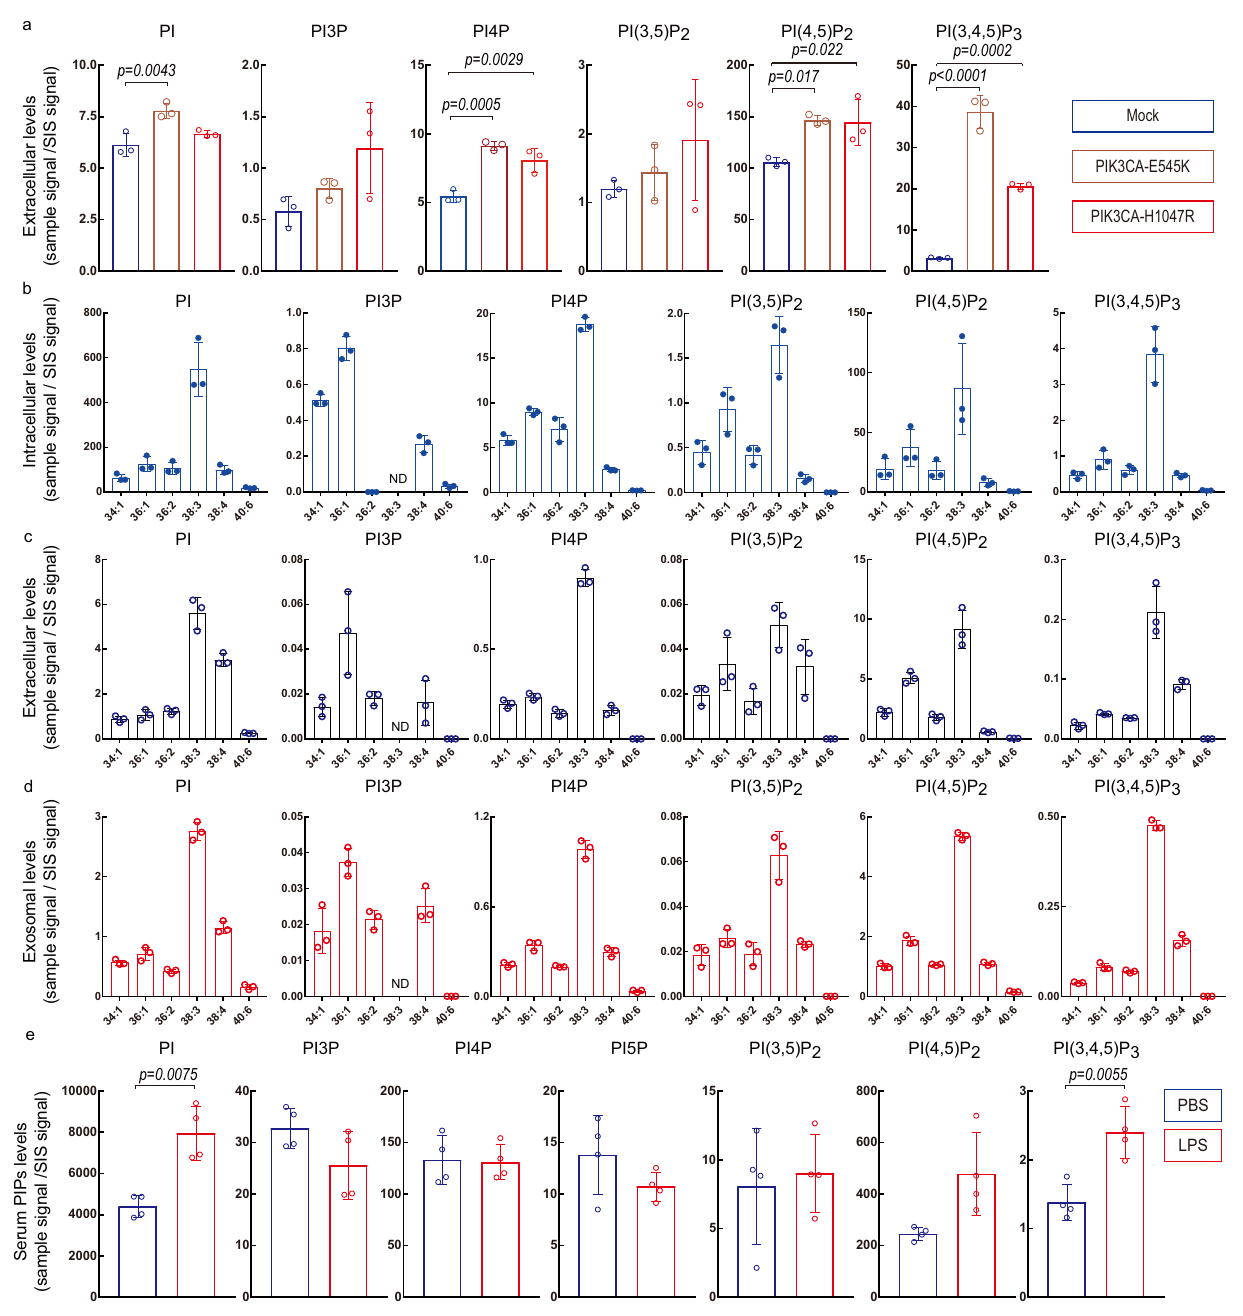
Fig. 4 Application of PRMC-MS to phosphoinositide measurement in liquid samples. a Quanti fi cation of the indicated phosphoinositides in CM of HEK293T cells transfected with either control expression vector (Mock) or vector expressing either mutant E545K or H1047R PIK3CA. CM was collected at 24 h post-transfection. Data were the mean ± SD ( n = 3 biologically independent samples) and representative of three independent experiments. Statistical analysis was performed using a two-sided Dunnett ’ s t -test. b – d Quanti fi cation of the indicated phosphoinositide acyl variants in b cell pellets, c CM, and d exosomes derived from LNCap cell cultures. PI5P and PI(3,4)P 2 were not detected. Data were the mean ± SD ( n = 3 biologically independent samples). e Quanti fi cation of the indicated phosphoinositides in plasma from WT mice that were intraperitoneally injected with either vehicle (PBS) or 50 mg/ml lipopolysaccharide (LPS) and analyzed after 2 h. PI(3,4)P 2 was not detected in either case. Data were the mean ± SD of total acyl variants of the indicated phosphoinositide classes ( n = 4 biologically independent samples). Statistical analysis was performed using two-sided unpaired Welch ’ s t -test. Source data are provided as a Source Data fi